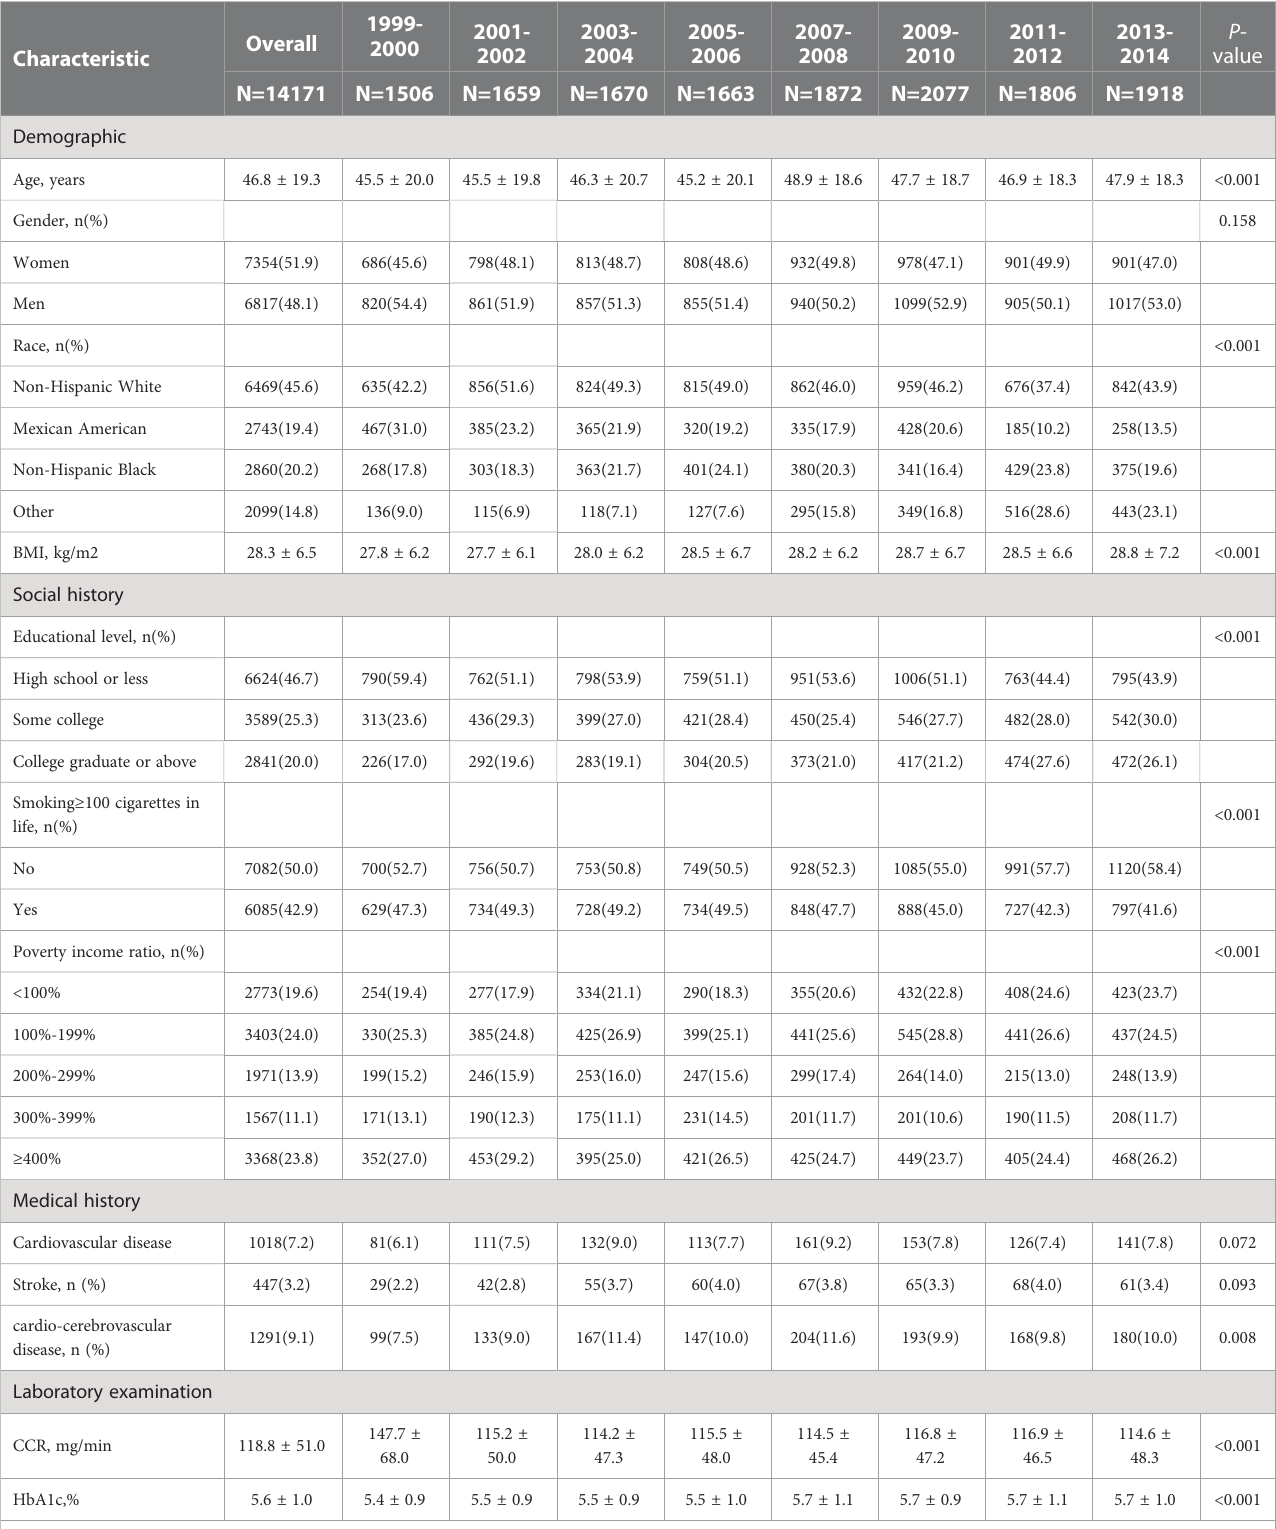
TABLE 1 Characteristics of included general adults in NHANES from 1999 – 2002 to 2011 –